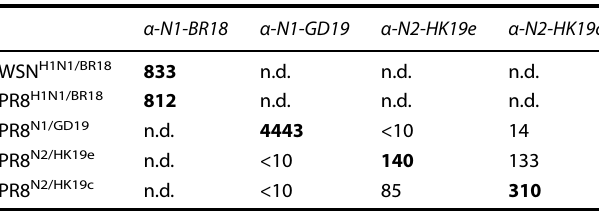
Table 1. NAI titres from the indicated reassortant viruses and antisera.